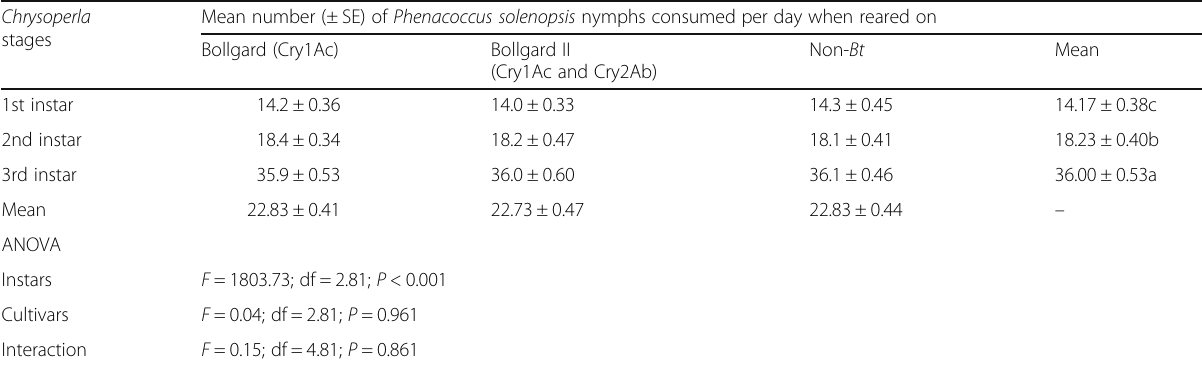
Table 4 Predatory potential of Chrysoperla zastrowi sillemi fed on Phenacoccus solenopsis reared on Bt and non- Bt cotton cultivars Chrysoperla